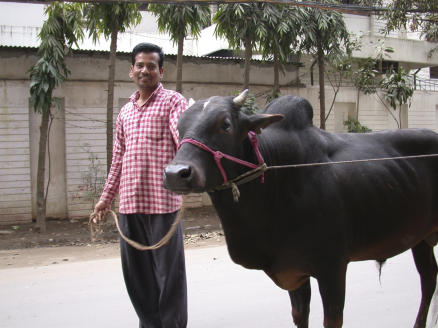
Cow and Proud Owner in Dacca, Bangladesh